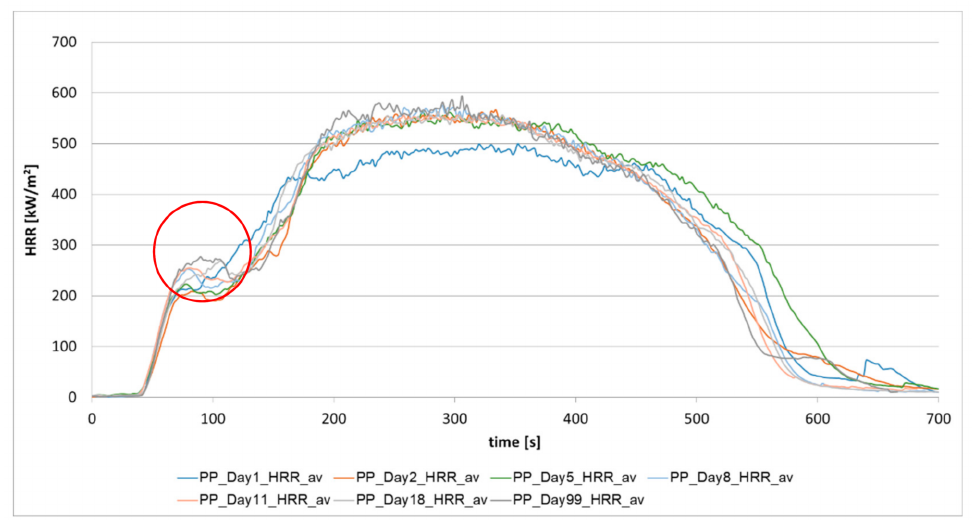
Figure 4. Heat Release rate of pressed granules of PP (m = 50 g) from the first day to day